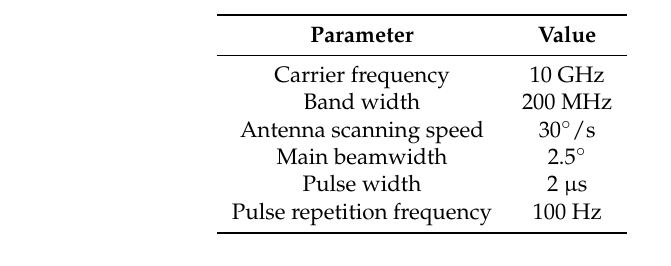
Table 8. Experimental Parameters.